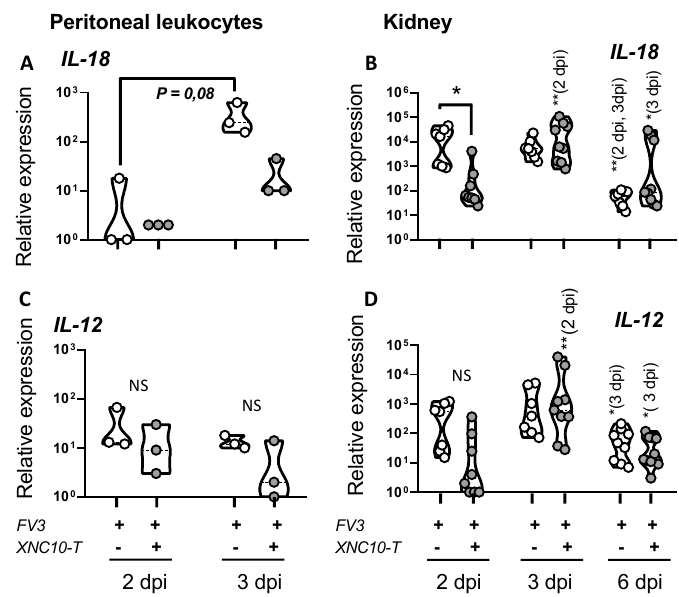
Figure 8. E ff ects of iV α 6T cell depletion on IL-18 and IL-12 responses. PLs and kidneys were collected from three week-old (stage 55) tadpoles that had been injected with 1 µ g XNC10 tetramers (XNC10-T) or vehicle control 1 day pre- and 1 day post-i.p. injection with 10,000 PFUs of FV3, at the indicated time points ( n = 8–9). Quantitative gene expression of IL-18 ( A , B ) and type IL-12 ( C , D ) was determined relative to an endogenous control (GAPDH) and relative expression was calculated against the lowest observed expression according to the ∆∆ Ct method ( n = 9); * p < 0.05; ** p < 0.005, above the line denotes statistically significant di ff erences between the di ff erent treatment groups; significant di ff erences between time points within each treatment group is indicated within parentheses; NS indicates no significant di ff erences (One way ANOVA followed by Tukey’s multiple comparisons